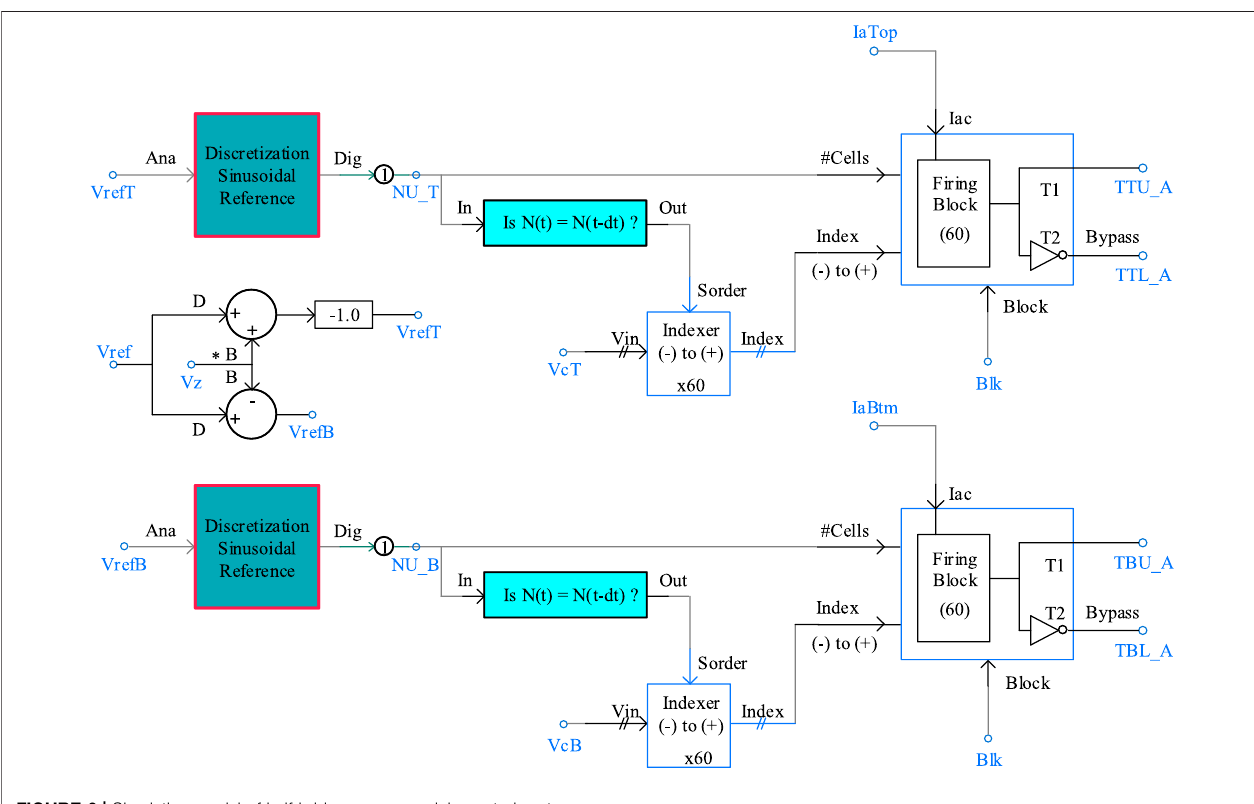
FIGURE 6 | Simulation model of half-bridge power module control